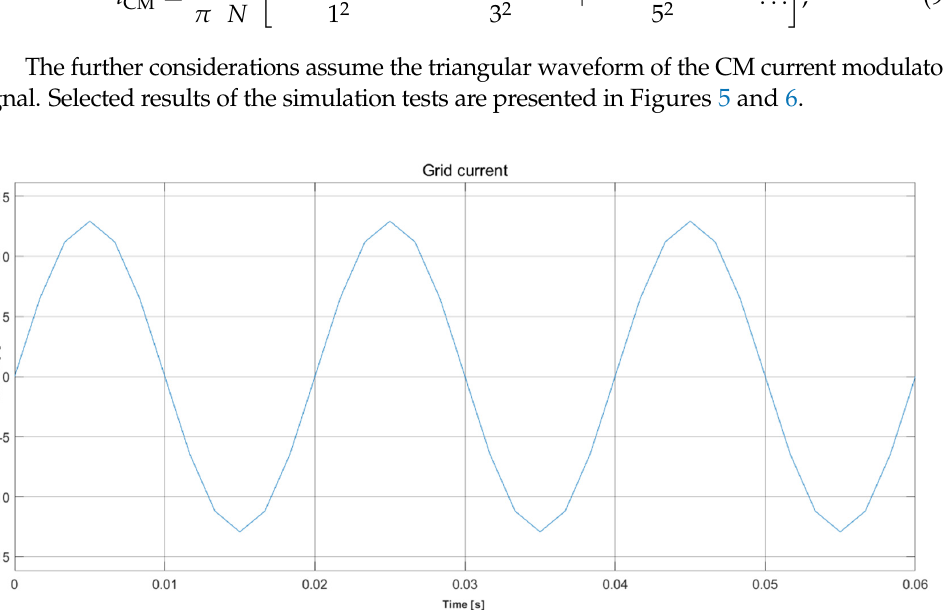
Figure 5. The waveform of the grid current ( i L1 ) drawn by the rectifier with the current modulator (the current modulator is based on an ideal current source).